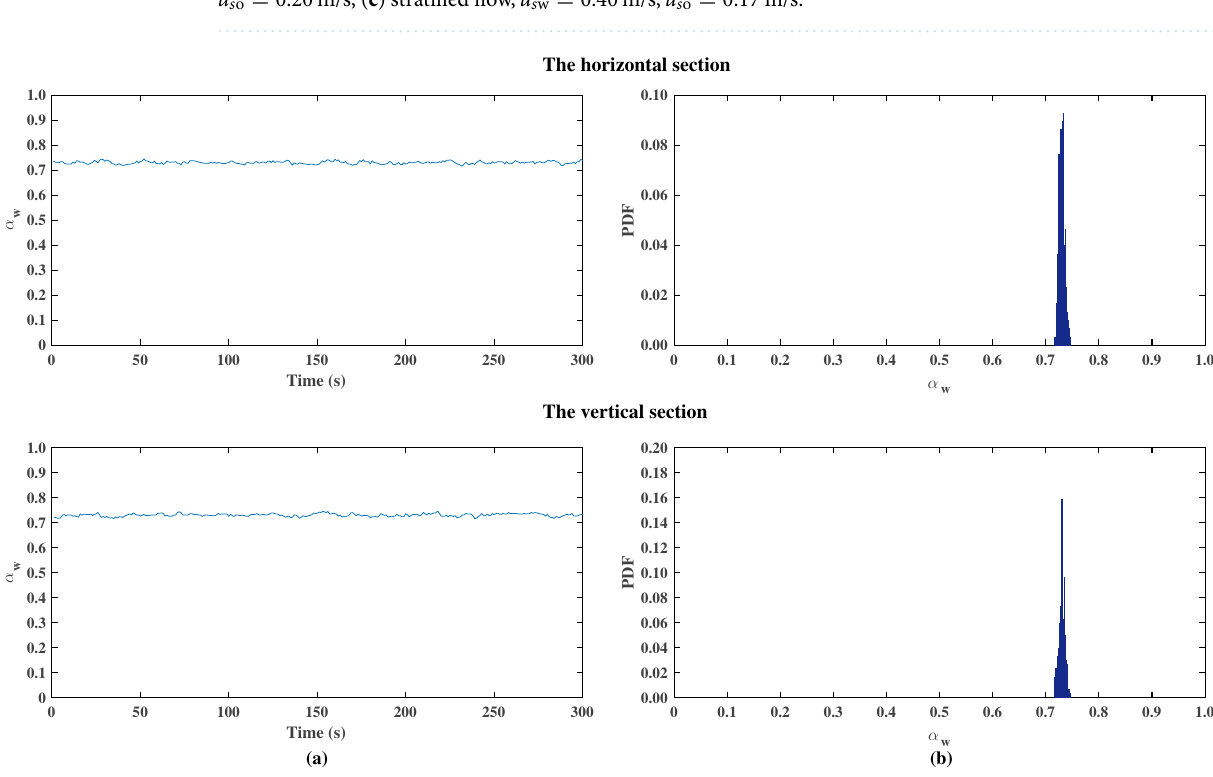
Figure 4. Typical evolution of the cross-sectional average water holdup α w and PDF for oil–water pipe flow: dispersion of oil in water ( u s w = 0.16 m/s, u s o = 0.07